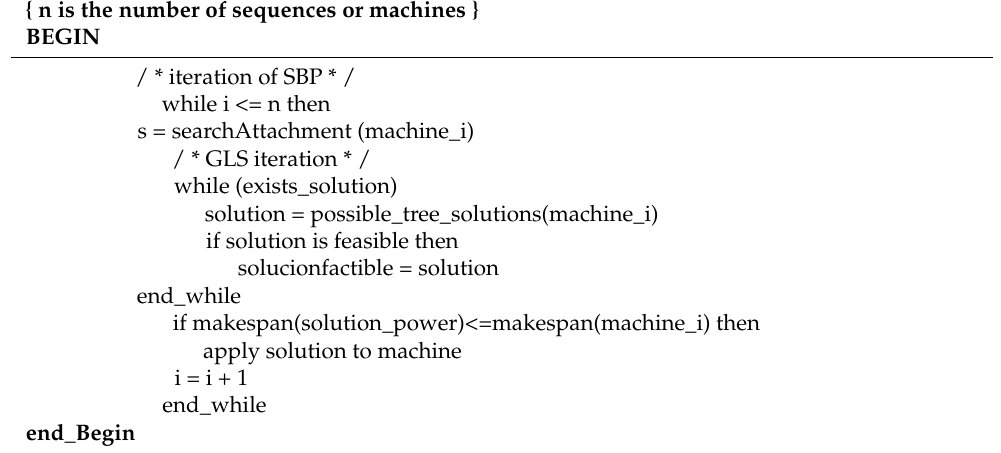
Table 2. Solution selection